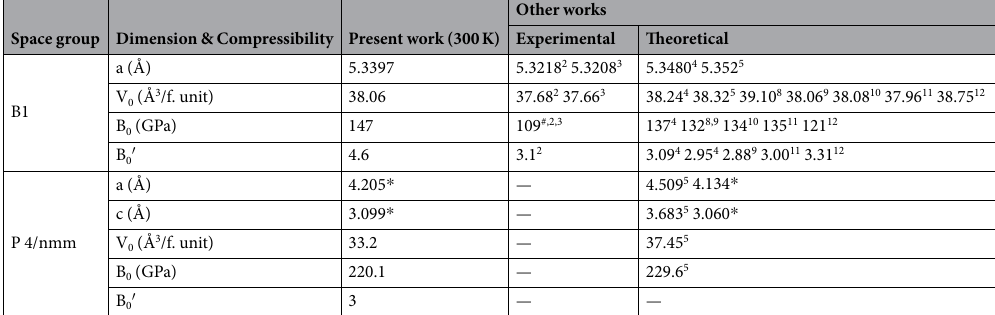
— — Table 1. Lattice parameters and compressibility of ThC at ambient and high pressure obtained from experiments and calculations. All calculation results were obtained at zero pressure and 0 K. * Obtained at 58.3 GPa. # The stoichiometry is ThC 0.76